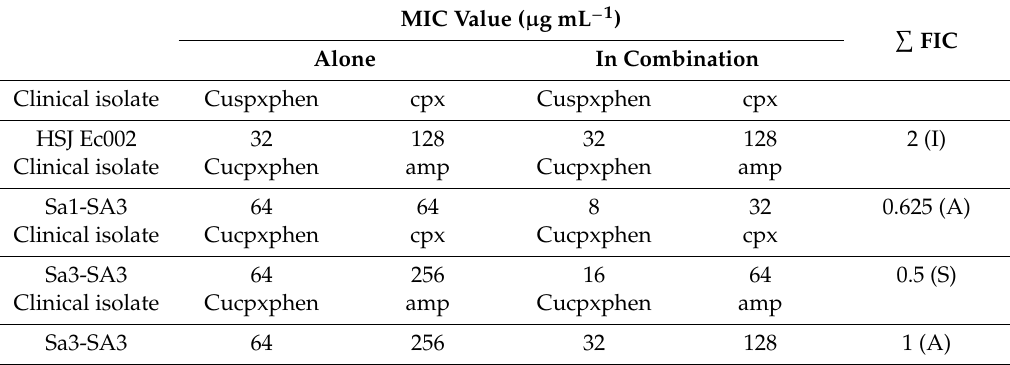
Table 5. MIC values of Cucpxphen, Cuspxphen, cpx and amp alone or in combination obtained from the checkerboard method. The MIC values and respective FIC index were determined against three clinical isolates (MDR isolate of E. coli HSJ Ec002 and MRSA isolates Sa1-SA3 and Sa3-SA3), from two independent